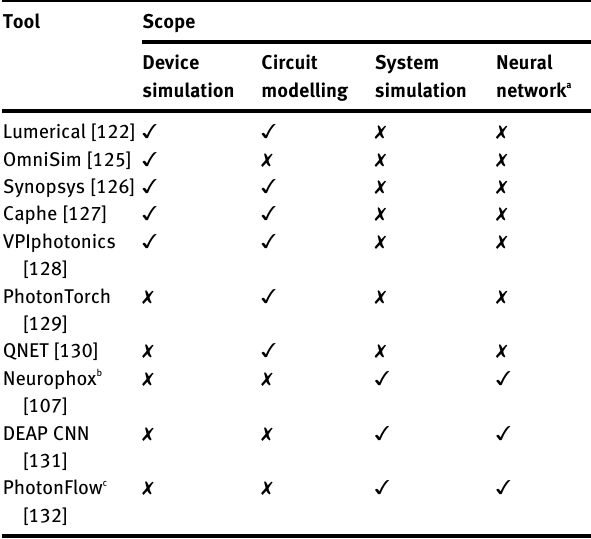
Table  : Comparison of various photonic tools versus their scope.